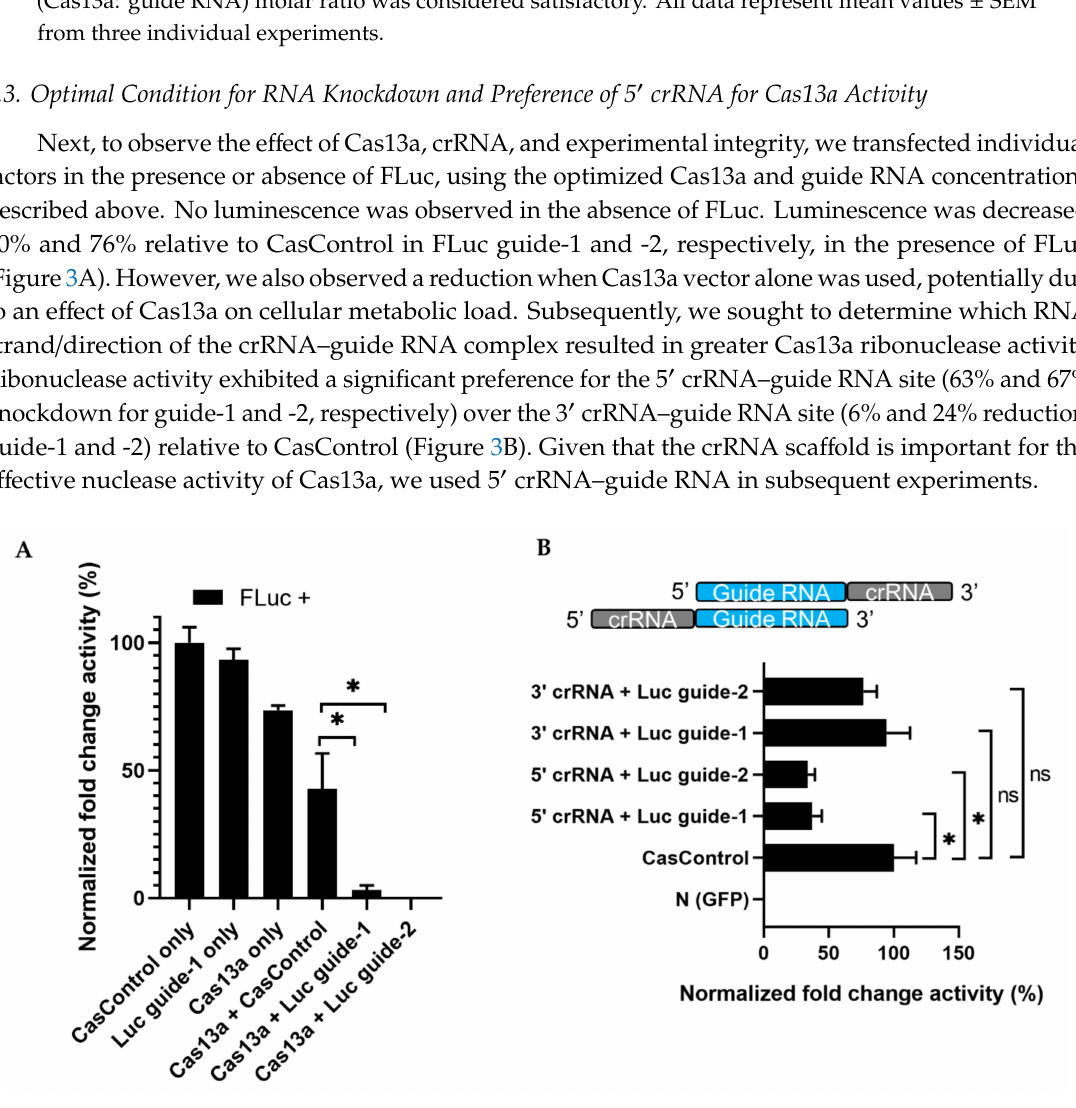
Figure 3. RNA knockdown and preference of Cas13a functionality for 5 (cid:48) crRNA–guide RNA. ( A ) Knockdown of FLuc: FLuc + , presence of firefly luciferase during transfection; CasControl only, nontargeting guide only; Luc guide-1 only, guide RNA for target FLuc; Cas13a only, Cas13a plasmid without any guide; Cas13a + CasControl, Cas13a plasmid and nontargeting guide plasmid transfection; Cas13a + Luc guide-1 / 2, targeted guide-1 / 2 and Cas13a. The FLuc was used as a target transcript while RLuc was used as an internal control. ( B ) Preference of Cas13a functionality for 5 (cid:48) crRNA–guide RNA complex: N (GFP), negative control; CasControl, nontargeting guide RNA; 5 (cid:48) / 3 (cid:48) crRNA + Luc, Cas13a with 5 (cid:48) or 3 (cid:48) crRNA–guide RNA target (FLuc) guide-1 / 2. The target transcript and internal control were same as ( A ). All data represent mean values ± SEM from three individual